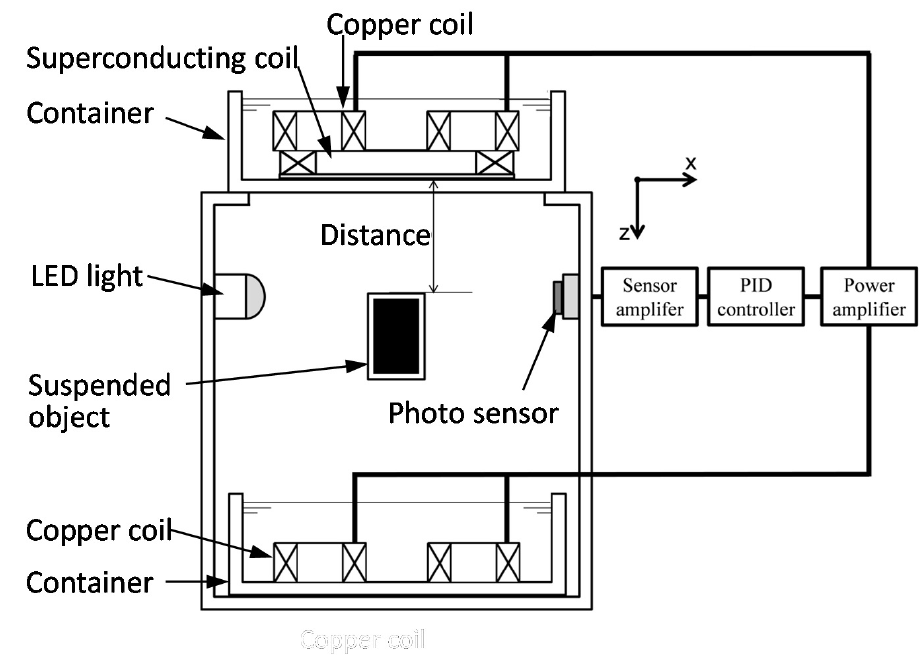
Figure 1. Schematic illustration of suspension system using persistent current in superconducting coil.